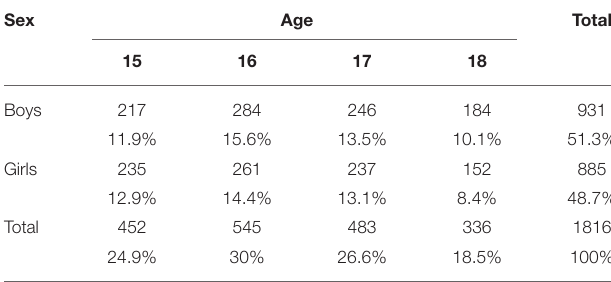
TABLE 1 | Distribution of the sample by sex and